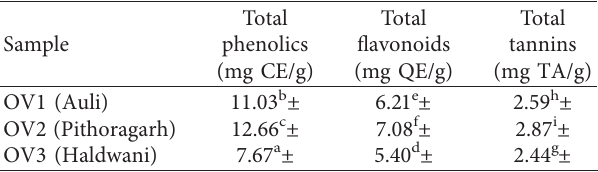
Table 7: Chemical composition of methanolic (OVM) extracts of O. vulgare .